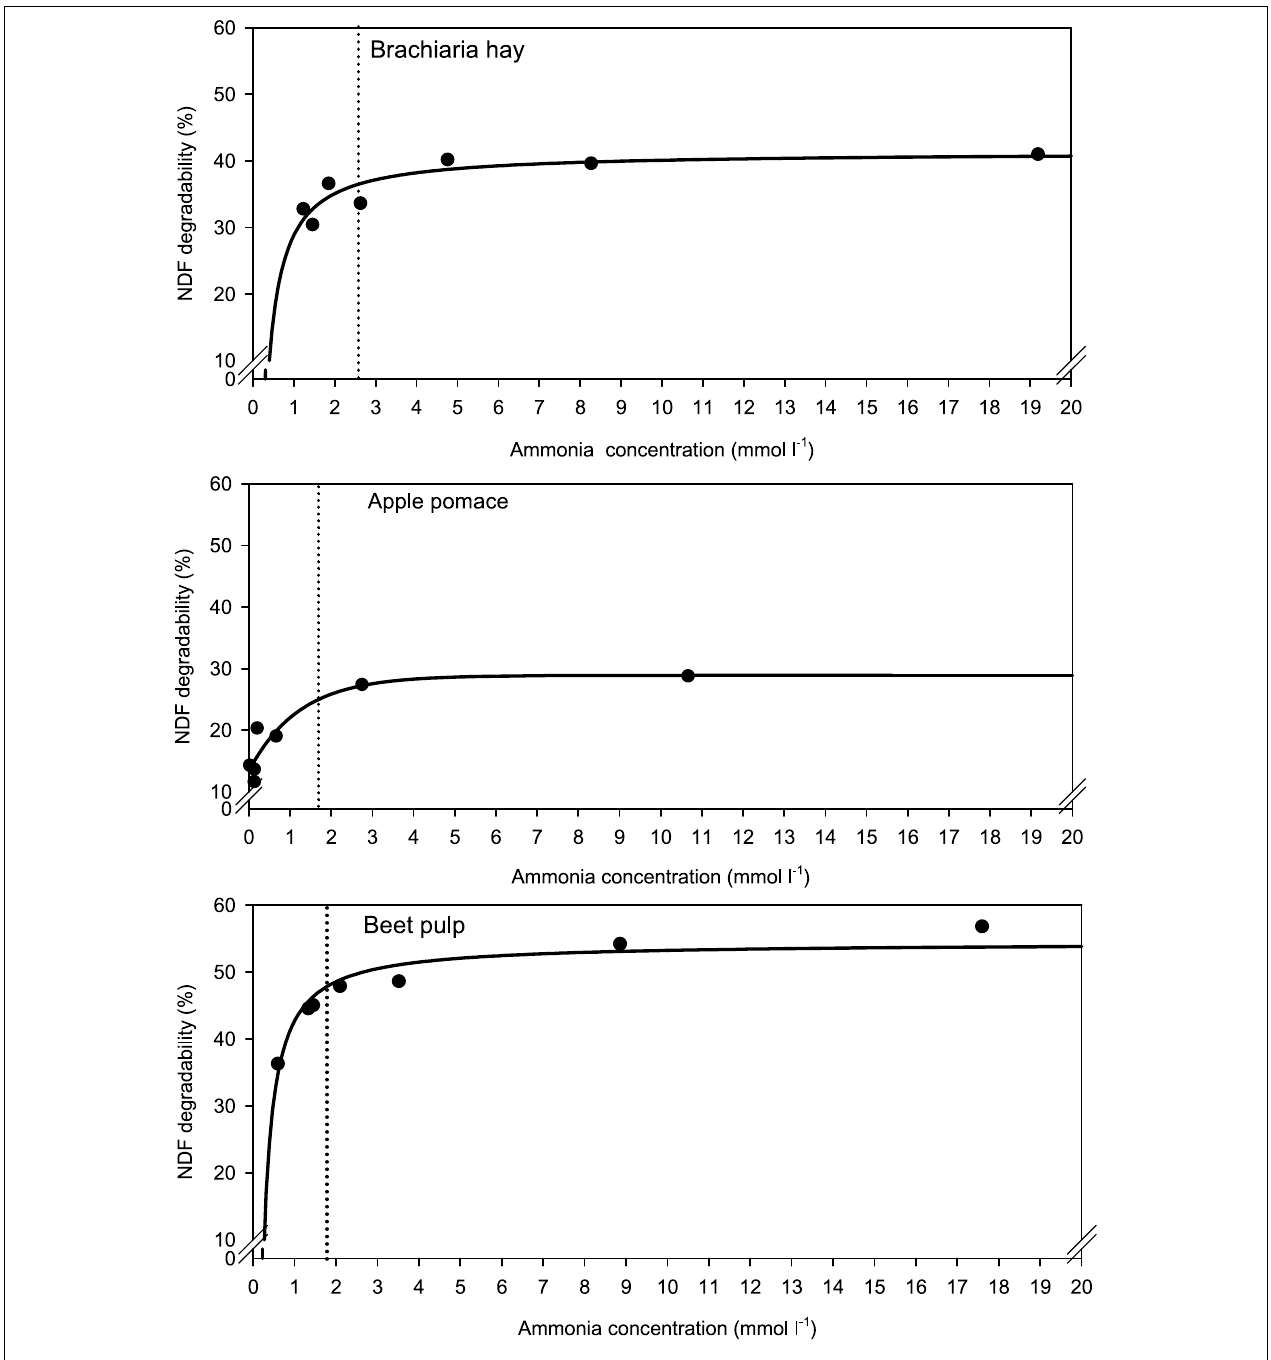
FIGURE 3 | Relationship between apparent neutral detergent fiber (NDF) degradability and incubation fluid ammonia concentration. The intersection between the vertical dotted line and the x-axis represents the ammonia concentration at which 95% of the calculated maximal degradability was achieved. For brachiaria hay: y = 41 . 4 ( ± 1.46; P < 0 . 001 ) − 12.5 ( ± 3.02; P = 0 .0090) x − 1 , R 2 = 0 . 775 , SE = 2 . 15 ,